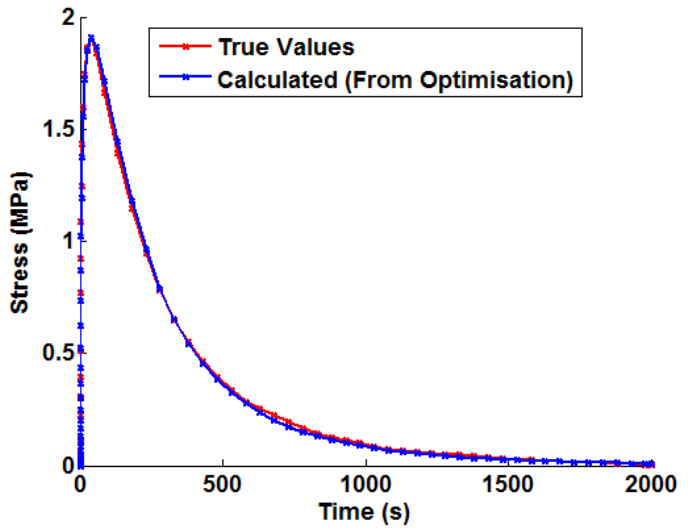
Figure 5. An example of the Green’s function approximation (shown in Equation (10)) fitted to the von Mises stress history from an uncoupled thermoelastic FEA simulation (unit temperature